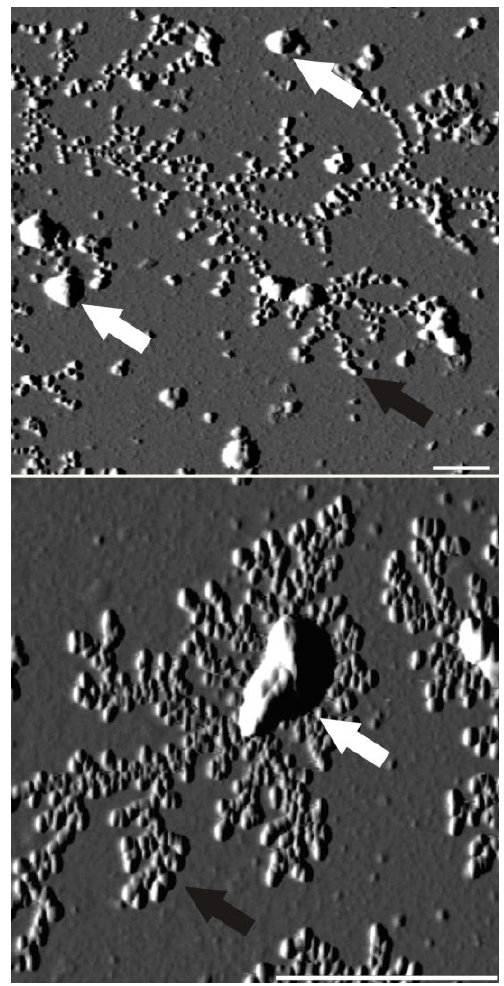
FIGURE 2. Representation of ultramicroforms as tree-like structures found in A. laidlawii PG8 (top) and M. gallisepticum S6 (bottom) cells cultivated in unfavorable conditions. White arrows = “typical” mycoplasma cells, black arrows = ultramicroforms. Bars correspond to 1